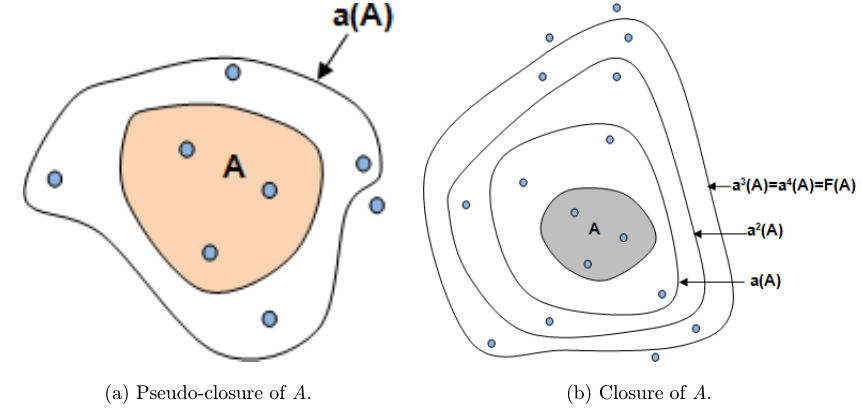
Fig. 2. Pseudo-closure and